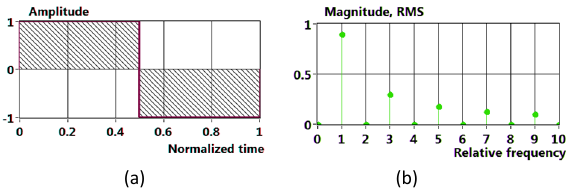
Fig.2: Waveform (a) and magnitude spectrum (b) of the pulse with relative duration t = (64/1000).